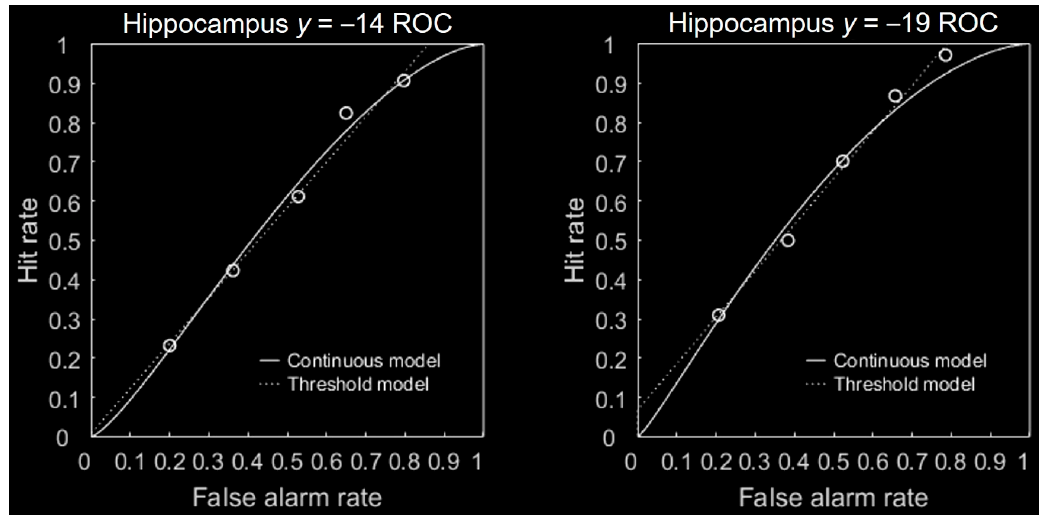
Figure A2. Hippocampal ROCs (circles) with the best-fit continuous unequal variance model and two-high threshold model ROCs (key at the bottom right of each ROC).